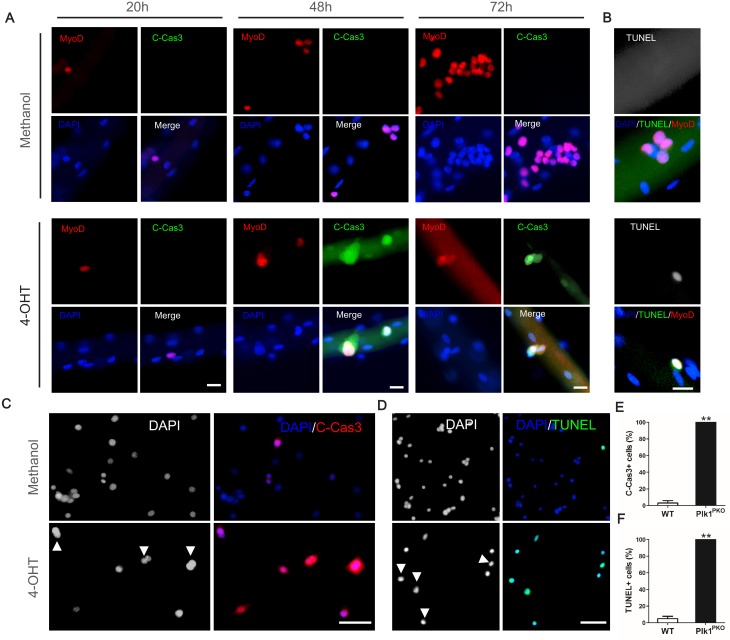
Plk1 deletion leads to apoptosis of MuSCs.(A) Representative images of MyoD (red) and cleaved Caspase-3 (green) staining in MuSCs located on EDL myofibers cultured for 20, 48 and 72 hr, myofibers were isolated from Plk1PKO mice and treated with 4-OHT to induce deletion of Plk1 at time 0, Methanol is the vehicle control, scale bar: 10 μm, at least 10 cells from 10 single myofibers per mouse (n = 3 mice) were counted; (B) Immunofluorescence of Myod (red) and TUNEL (green) in MuSCs on EDL myofibers cultured for 42 hr, scale bar, 10 μm, at least 10 cells from 10 single myofibers per mouse (n = 3 mice) were counted; (C–D) Representative images of cleaved Caspase-3 (C) and TUNEL (D) staining in primary myoblasts at 48 hr after methanol or 4-OHT treatment, nuclei were counterstained with DAPI, arrowheads indicate cells arrested at M-phase, scale bar: 50 μm; (E–F) Quantification of percentages of Caspase-3+ (E) and TUNEL+ (F) cells, data represent mean ± s.e.m. (t-test: **p<0.01; n = 3, biological replicates (mice), three replicates/mouse, 25–50 myoblasts/replicate were analyzed).